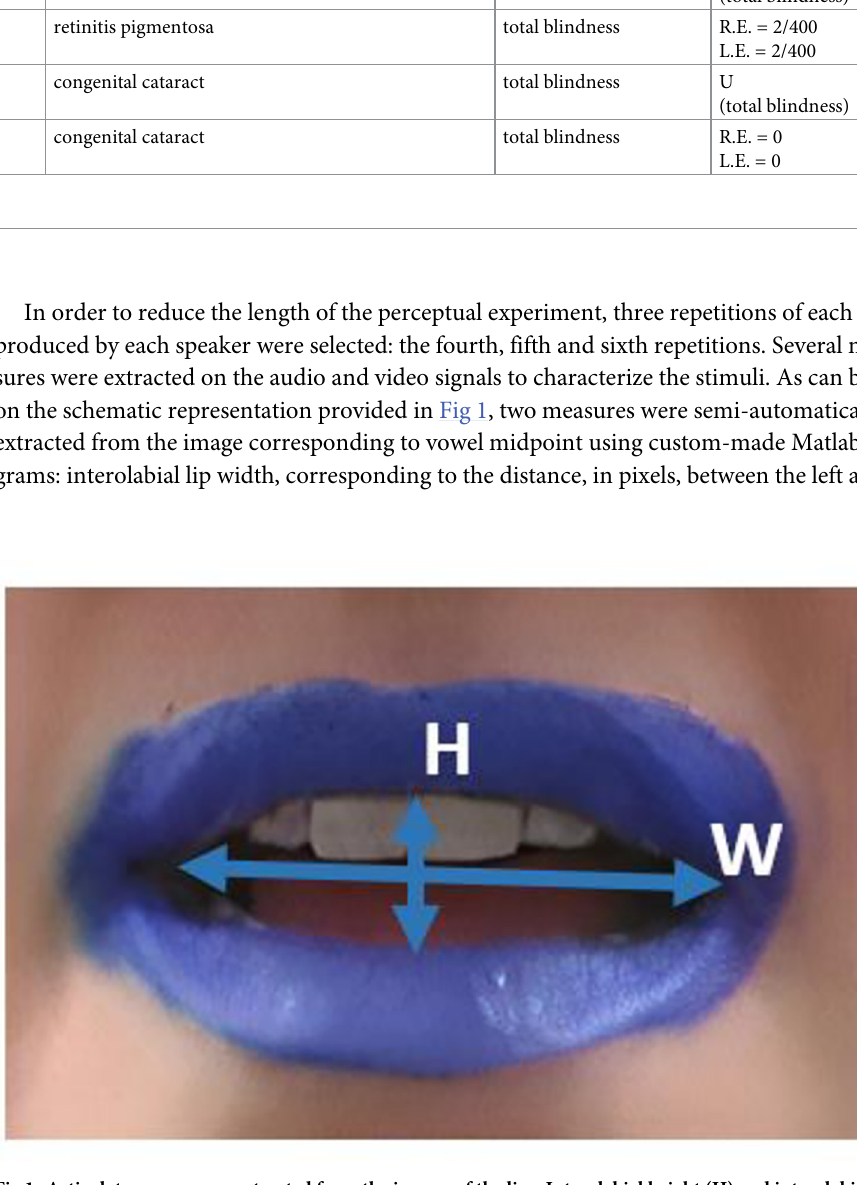
Fig 1. Articulatory measures extracted from the images of the lips: Interolabial height (H) and interolabial width (W).